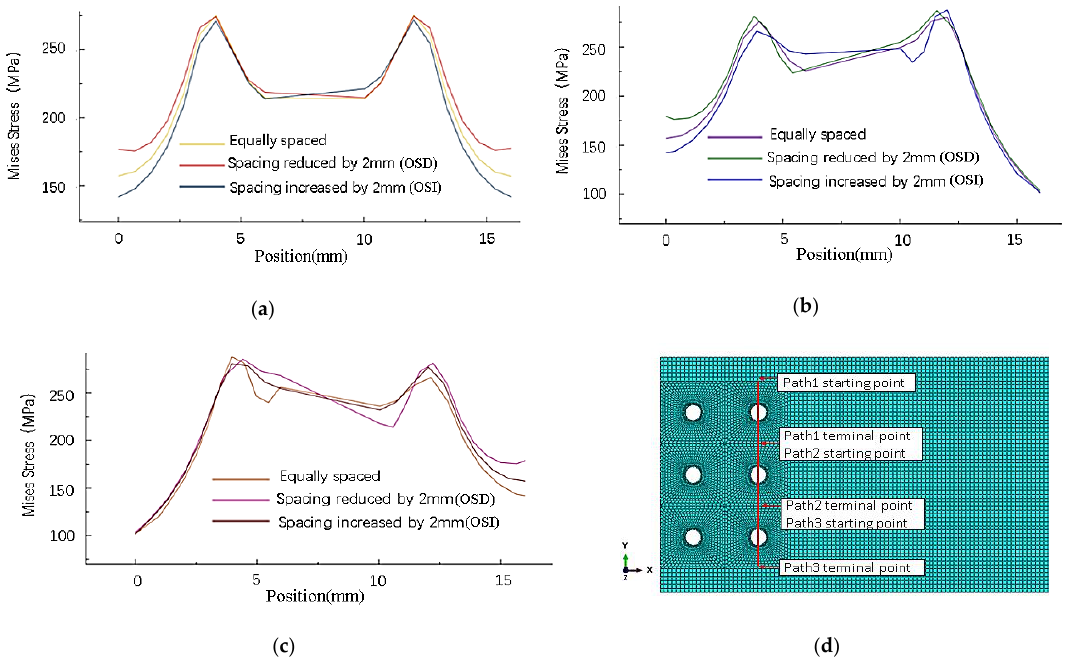
Figure 9. Mises stress distribution around a single rivet hole after changing the rivet spacing: ( a ) Mises stress distribution around No. 1 rivet hole; ( b ) Mises stress distribution around No. 2 rivet hole; ( c ) Mises stress distribution around No. 3 rivet hole; ( d ) Stress path setting around each rivet hole.